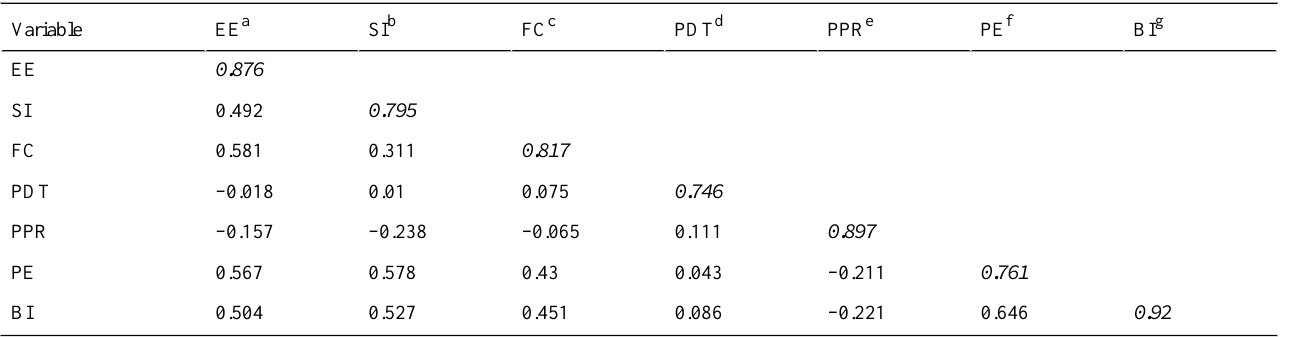
Table 5. Square root of average variance extracted of latent variables and correlation coefficient matrix. Italicized values represent square root of the average variance extracted; the values below them indicate the correlation coefficients.